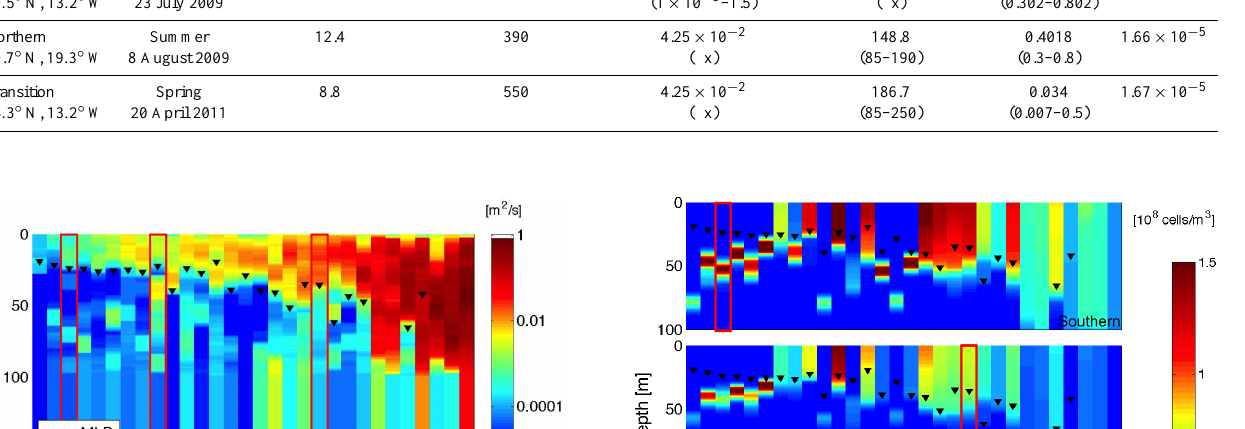
Fig. 8: Temporal evolution of (a) the relative change of the system per time step R and (b) the sum of squares S for the three reference stations. On the x-axis the time is given as the percentage of the total duration until the equilibrium is reached. The y-axis is in logarithmic scaling. Figure 9. Measured vertical mixing profiles aligned according to the mean mixing strength with increasing strength along the x axis as shown in the lower graph (logarithmic y axis).The red boxes indi- Fig. 9: Measured vertical mixing profiles aligned accord- cate the vertical mixing used for the model calibration at the south- ing to the mean mixing strength with increasing strength ern, northern and transition station (left to right). along the x-axis as shown in the lower graph (logarithmic y-axis).The red boxes indicate the vertical mixing used for the model calibration at the southern, northern and transition station (left to right).